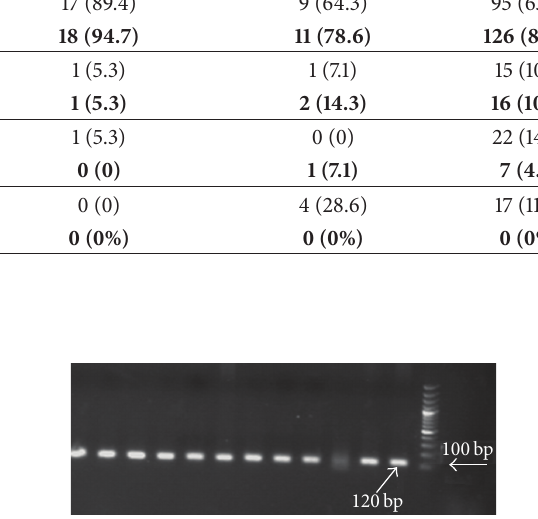
Figure 1: Agarose gel electrophoresis of nested PCR products from clinical specimens using species-specific oligonucleotide pairs for P. vivax .